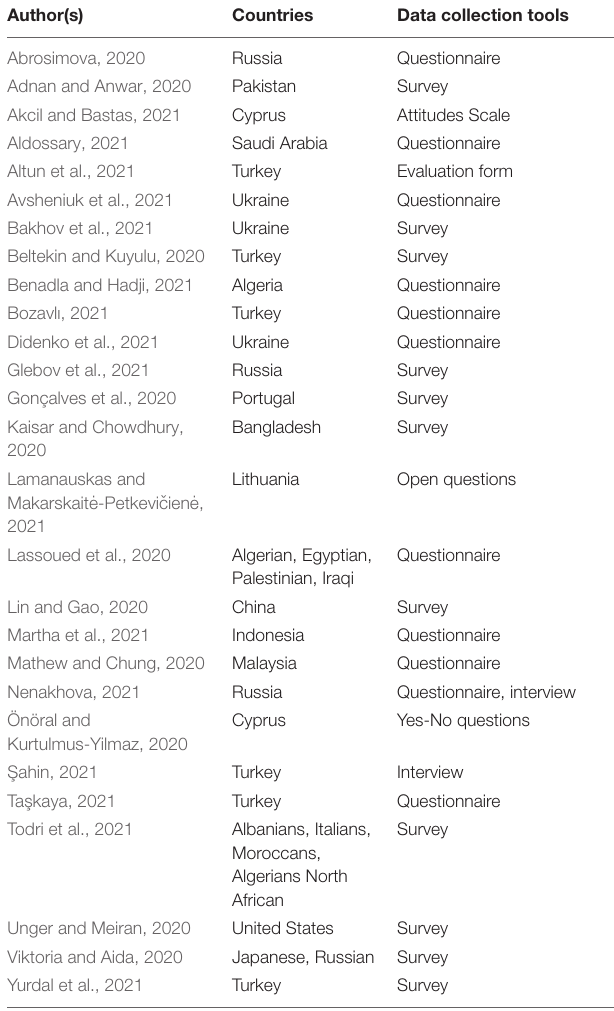
TABLE 1 | Countries and data collection